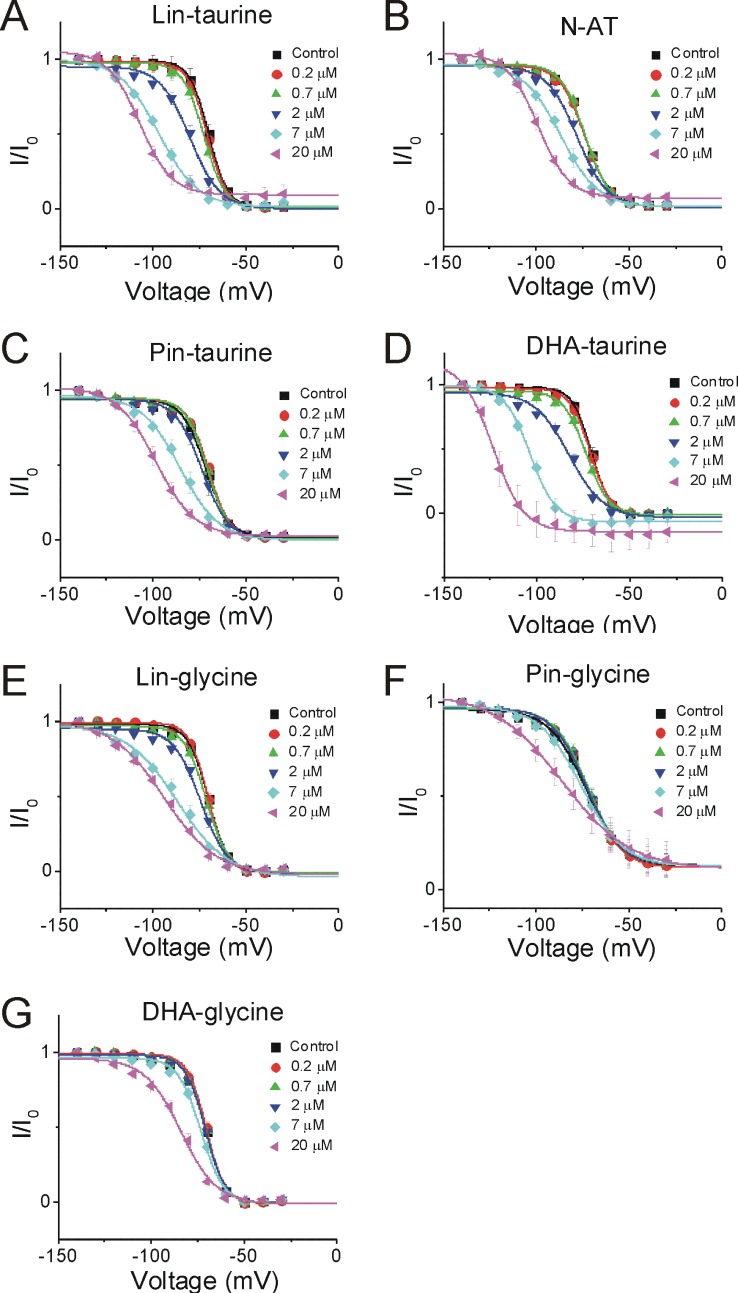
Internally normalized steady state inactivation curves for Nav1.5/β1.(A–G) PUFA-induced effects on Nav1.5/β1 voltage dependent inactivation normalized by each concentration for: (A) Lin-taurine, (B) N-AT, (C) Pin-taurine, (D) DHA-taurine, (E) Lin-glycine, (F) Pin-glycine, and (G) DHA-glycine.